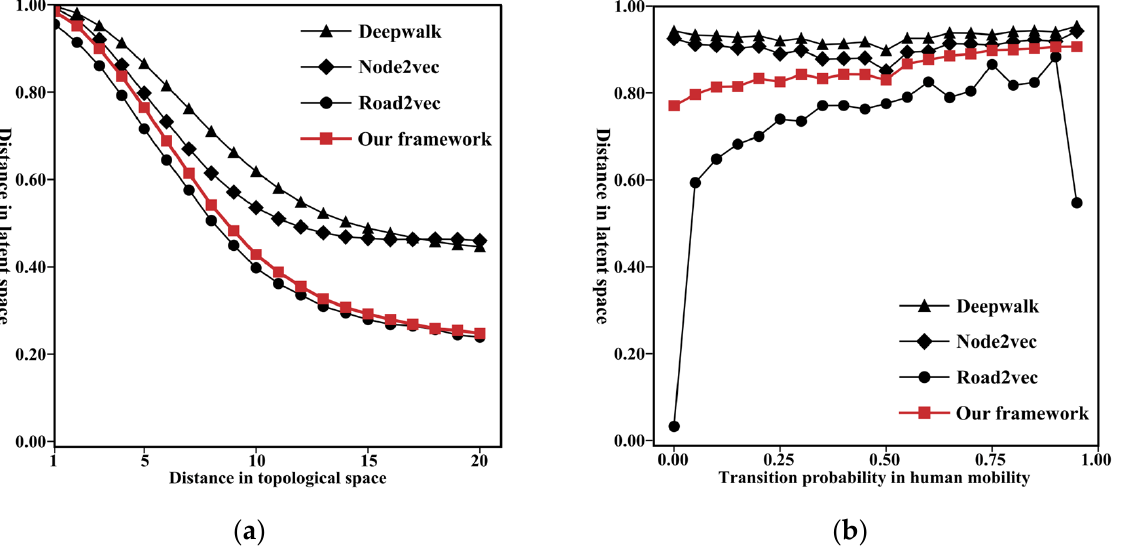
Figure 8. Relationships of the different distances in various spaces, including: ( a ) the distance in latent space and the corresponding topological distance; ( b ) the distance in latent space and the corresponding transition probability.